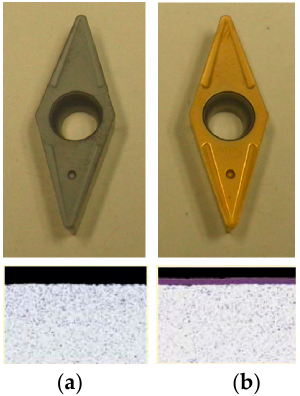
Figure 4. Types of coatings SECO used in tests called ( a ) HX; and ( b ) CP200.